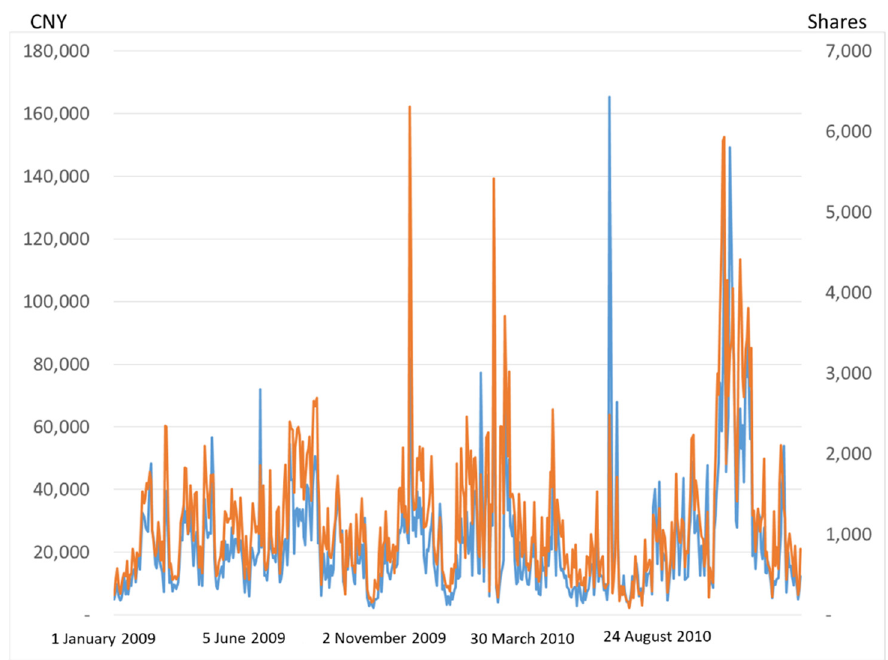
Figure 2. Daily turnover and volume from one of the brokerage tapes. Turnover (in CNY) is shown by the blue curve (left axis) and trading volume is shown by an orange curve (right axis).